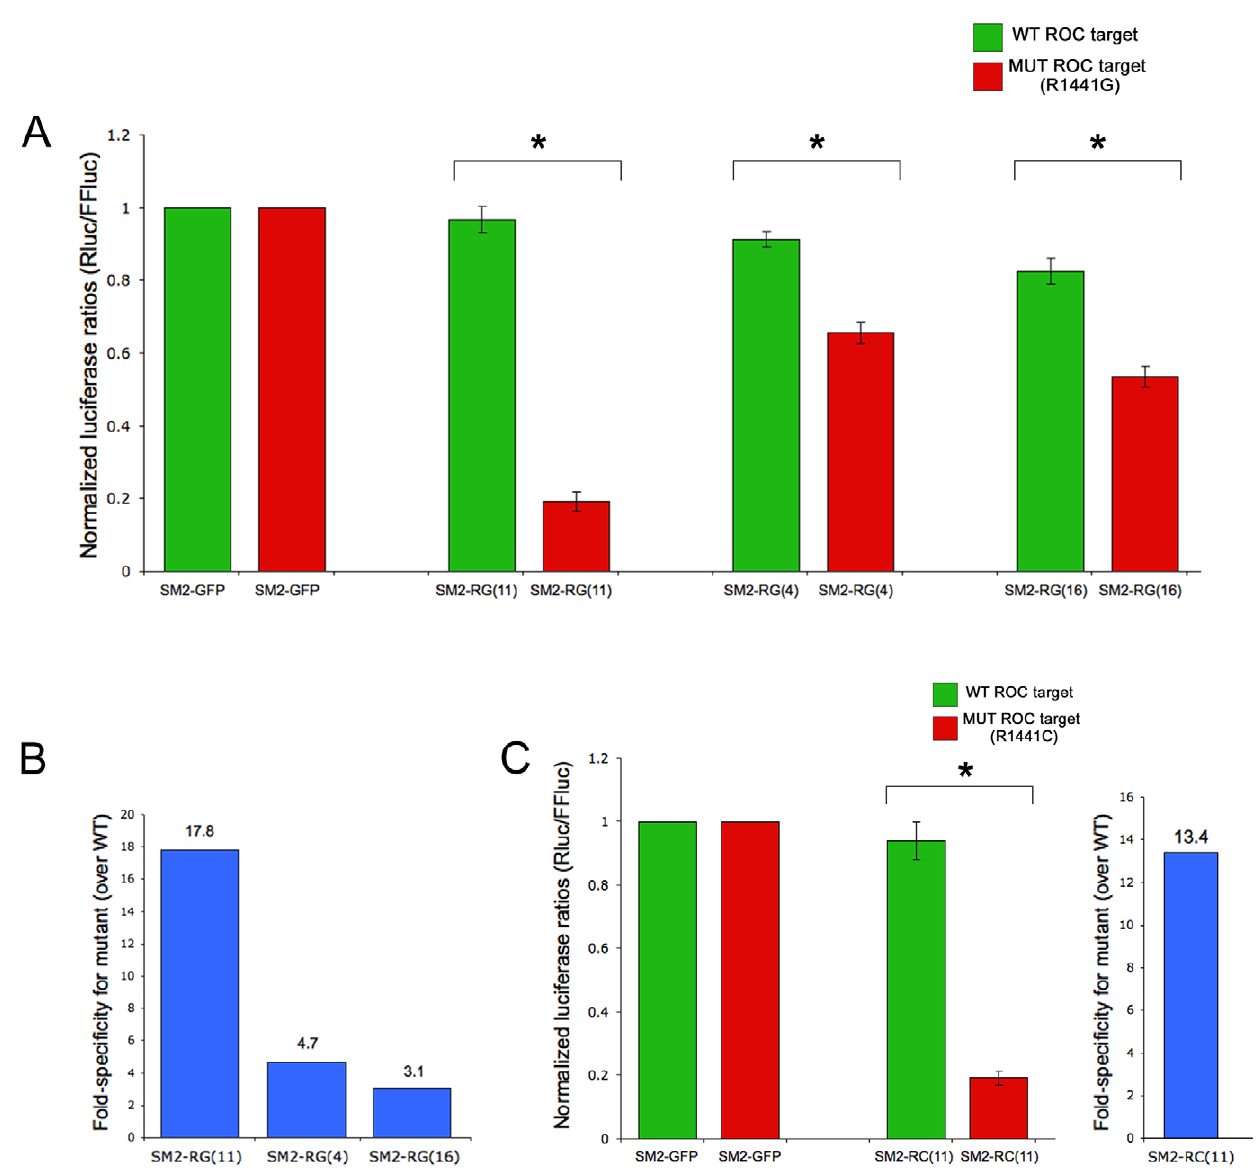
Figure 2. ASP-RNAi against R1441 LRRK2 alleles is effective when MRS is centrally located. A. Luciferase-based assays demonstrated that shRNA SM2-RG(11) is quite selective in recognizing mutant over wild-type LRRK2, and leads to potent silencing of the mutant target. Shifting of the MRS either 5 9 or 3 9 within the guide strand reduced both specificity and silencing strength of the resulting shRNAs. * denotes a p-value of , 0.01; n.s.= not significant. B. A representation of fold-specificity is shown, calculated by comparing silencing strength of shRNA towards mutant templates versus wild-type template (for example, 81% knockdown of R1441G by SM2-RG(11) compared to 4.5% knockdown of wild-type R1441 results in 17.8- fold specificity). C. Similar experiments using a distinct shRNA and template to test R1441C ASP-RNAi showed that placing the MRS at position 11 is also effective for a different R1441 allele.